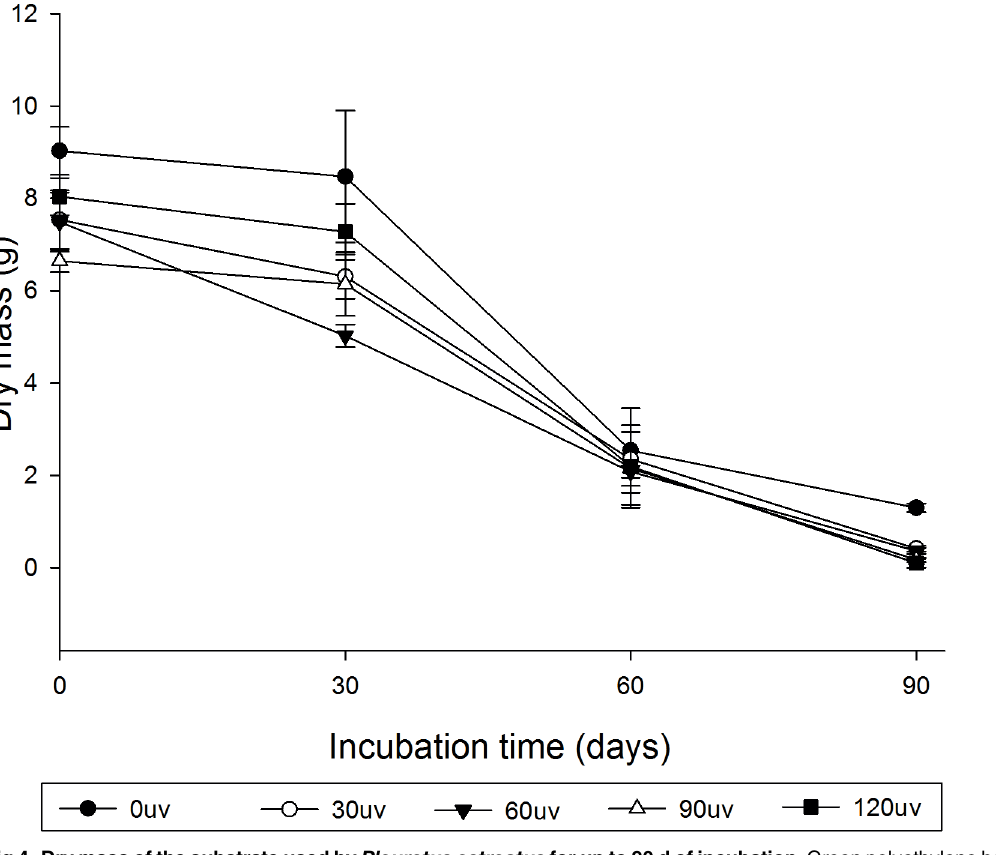
Fig 4. Dry mass of the substrate used by Pleurotus ostreatus for up to 90 d of incubation. Green polyethylene before (0duv) and after 30 d (30duv), 60 d (60duv), 90 d (90duv) or 120 d (120duv) of exposure to sunlight.